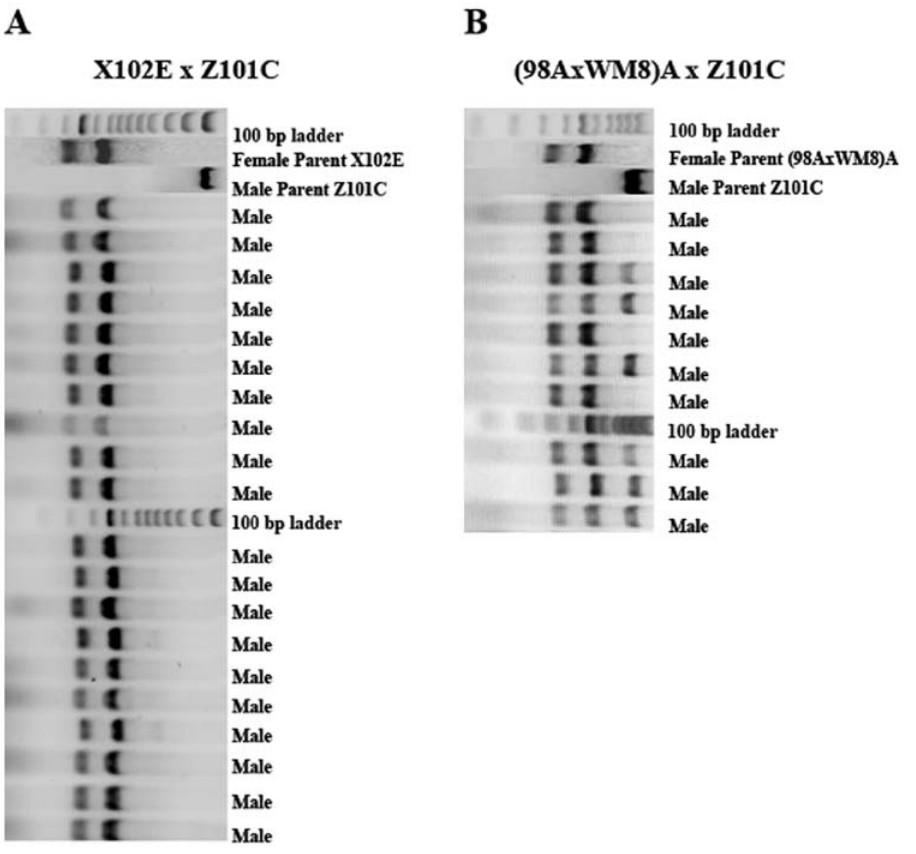
Figure 3. mtDNA content and sex of triploid progeny from two females crossed to the same male. A) Female-biased mother. All progeny were males, unlike with diploids from the same cross, where all but two were females (Fig. 1A). All progeny contain only the mother’s mtDNA, as with diploids from the same cross (Fig. 1A). B. Male-biased mother. All progeny were males, as with diploids from the same mother (Fig. 2B). Of these, 6 carried the mtDNA of both parents and 3 carried only the mother’s